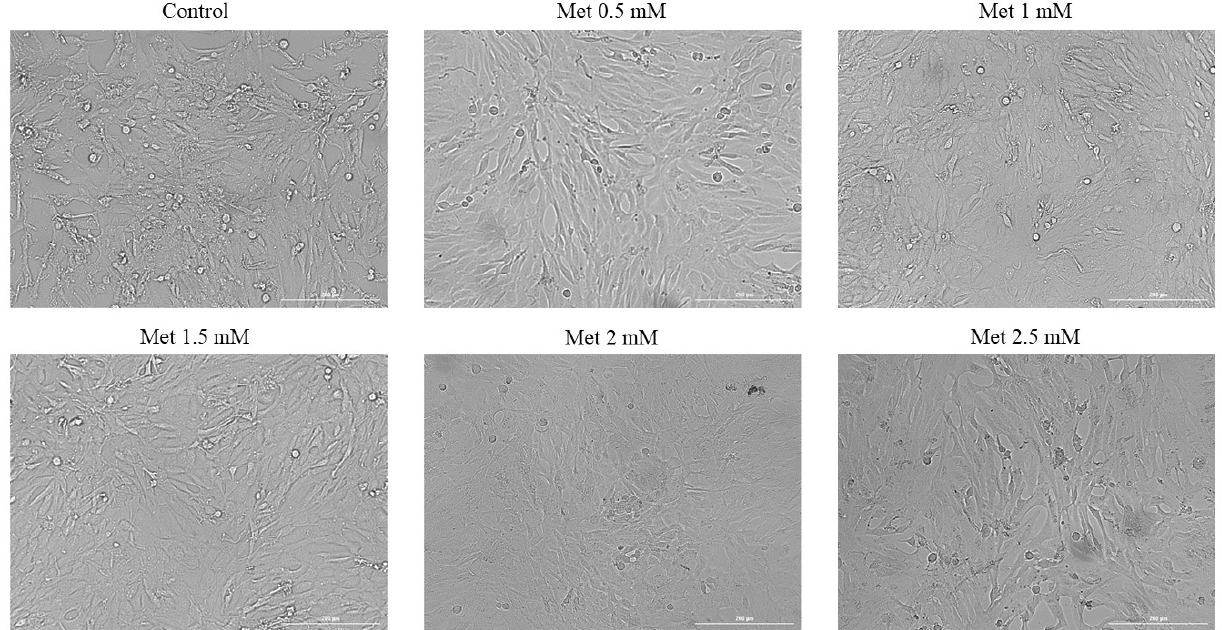
Figure 3. Morphology and confluence of HepaRG cells following the 24 h treatment with Met 0.5, 1, 1.5, 2 and 2.5 mM. The scale bars indicate 200 µ m.